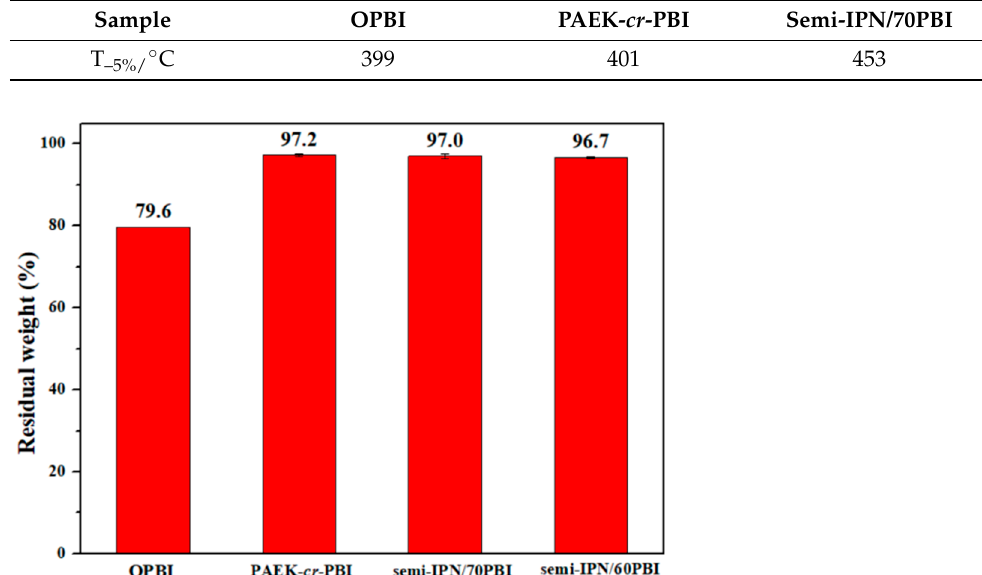
Table 1. 5% weight loss temperature for dry membrane.